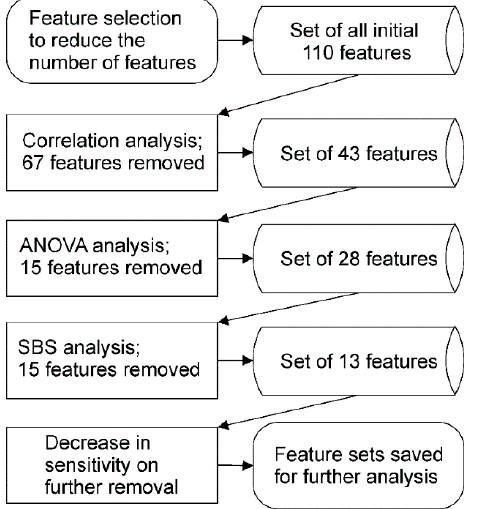
Figure 2. First feature selection scheme using correlation analysis, ANOVA, and backwards sequential feature selection with the number of features removed in each step.